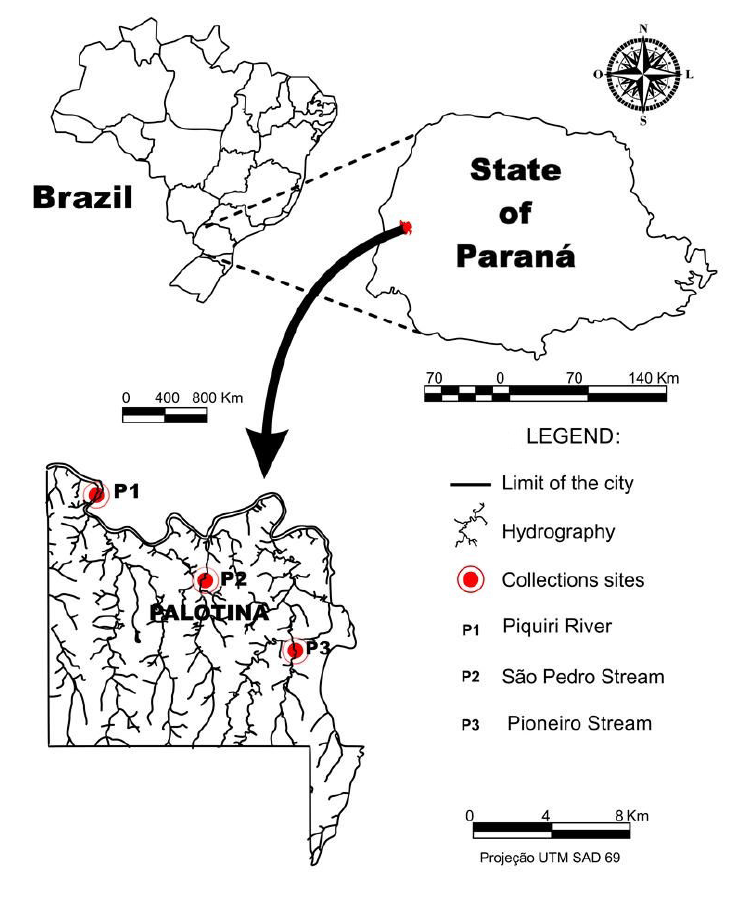
Figure 1. Collection sites of Malaysian prawn Macrobrachium rosenbergii along the Piquiri River basin municipality of Palotina, State of Paraná, southern